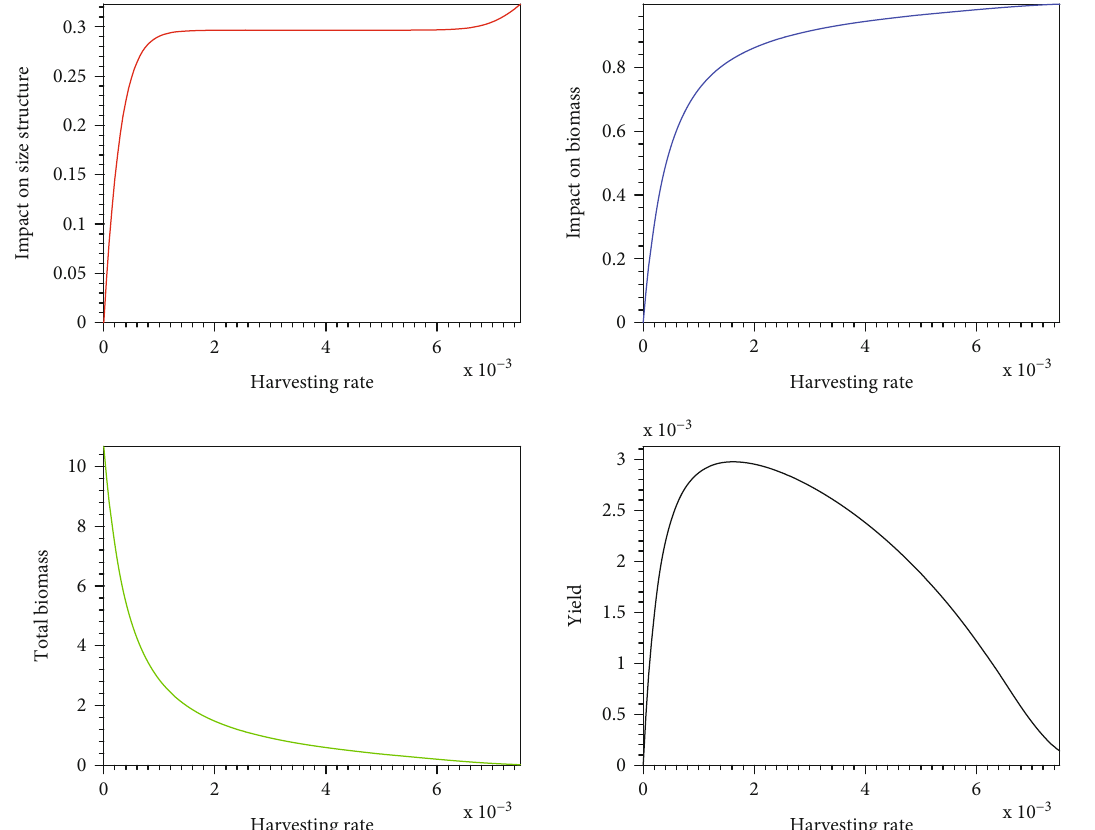
Figure 5: Simulation results, using system (18), including only the Nile tilapia. The fi gures show the dependence of impact on size structure (red curve), impact on biomass (blue curve), total biomass (green curve), and yield (black curve) with respect to equal harvesting rates, i.e., ! = ð h , h Þ . The initial values are chosen positive, and other parameter values can be found in Tables 3 – h